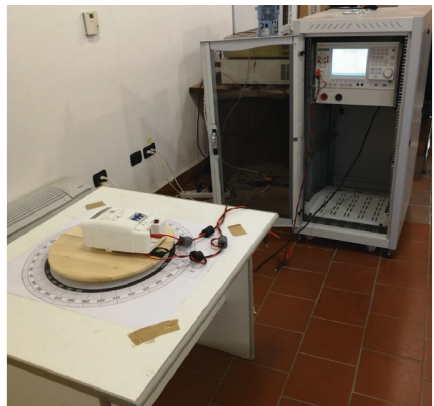
Figure 18: Measurements in normal installation